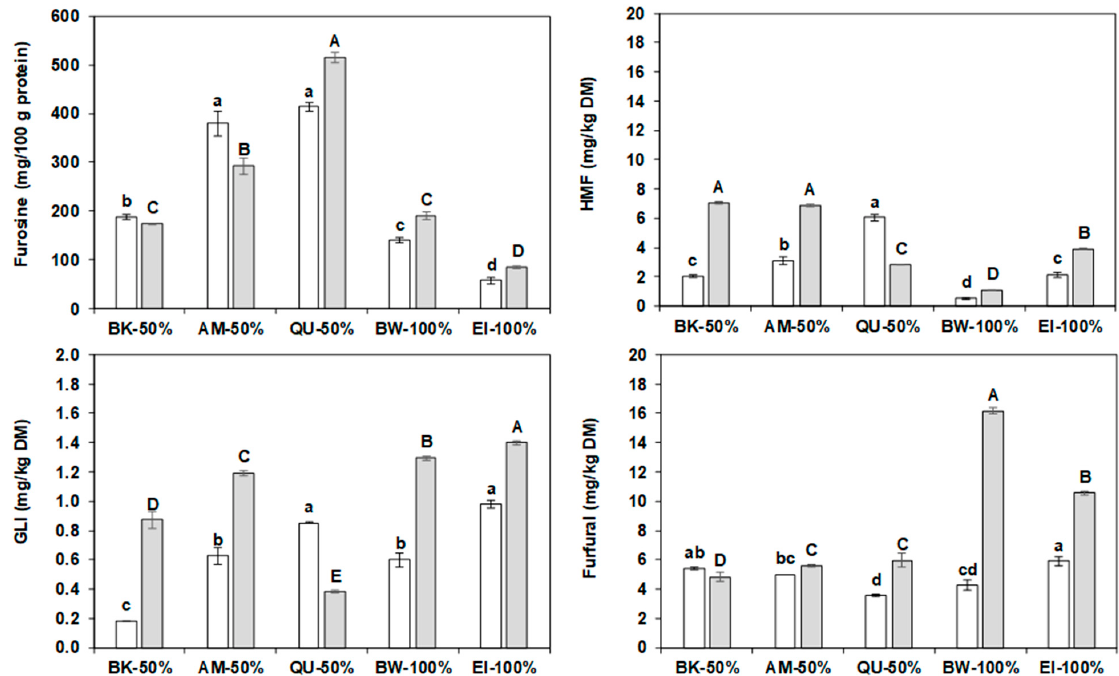
Figure 5. Furosine (mg/kg protein), hydroxymethylfurfural (HMF), glucosylisomaltol (GLI), and furfural (mg/kg DM) levels of the water biscuits. Empty bars: water biscuits prepared with 50% einkorn flour and 50% buckwheat (BK), amaranth (AM), or quinoa (QU) wholemeal, or 100% bread wheat (BW) flour or 100% einkorn (EI) flour. Grey bars: water biscuits prepared with 50% einkorn wholemeal and 50% buckwheat, amaranth, or quinoa wholemeal, or 100% bread wheat wholemeal or 100% einkorn wholemeal. The error bars represent the standard deviation; different lower-case letters indicate significant differences ( p < 0.05) among samples prepared with einkorn refined flour, while capital letters indicate significant differences ( p < 0.05) among samples prepared with einkorn wholemeal.